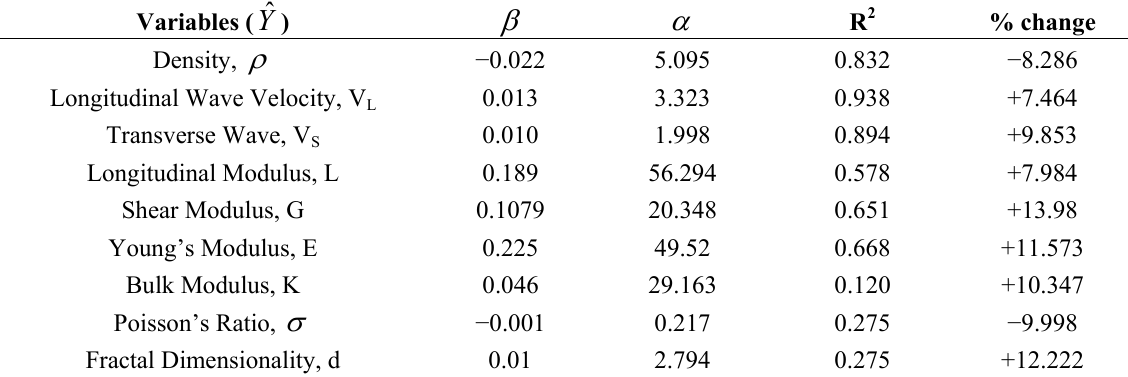
Table 3. Linear regression analysis of the variables ( Y ˆ =  x ˆ +  ) for various properties of glass (density,  ; longitudinal and shear ultrasonic velocities, v K , E ; Poisson’s ratio,  ; and fractal dimensionality,